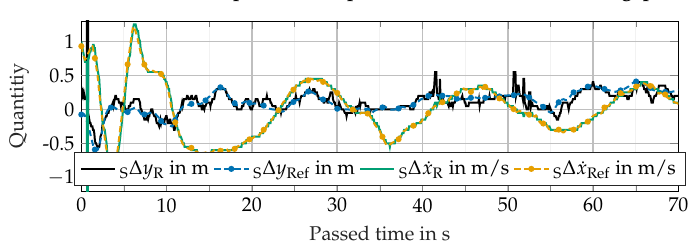
Figure 2. Variation of lateral distance and longitudinal speed between ego car and object of interest (OOI) in an ACC scenario. The left index “S” denotes the sensor coordinate system, “R” the radar sensor and “Ref” the GNSS-based reference